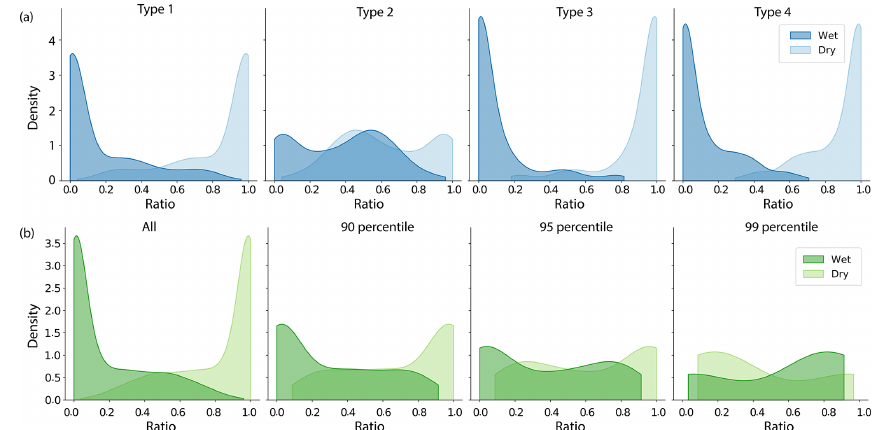
Figure 10. (a) Distribution of contribution of wet and dry depositions to total deposition in each type in WRF-Chem. (b) Distribution of contribution of wet and dry depositions to total deposition for all depositions and depositions over the 90th, 95th, and 99th percentile.